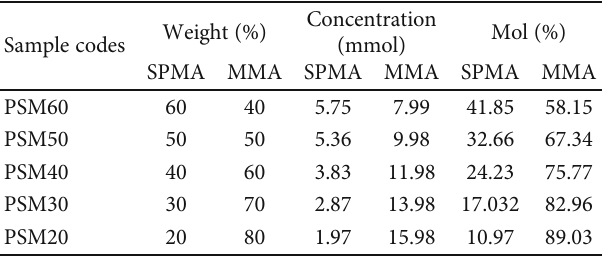
Table 1: Sample codes with concentration of SPMA and MMA. Sample